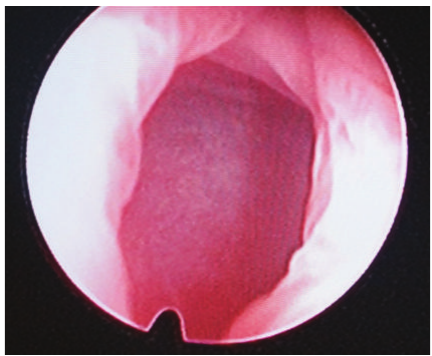
Figure 5: Endoscopic view of fistula.